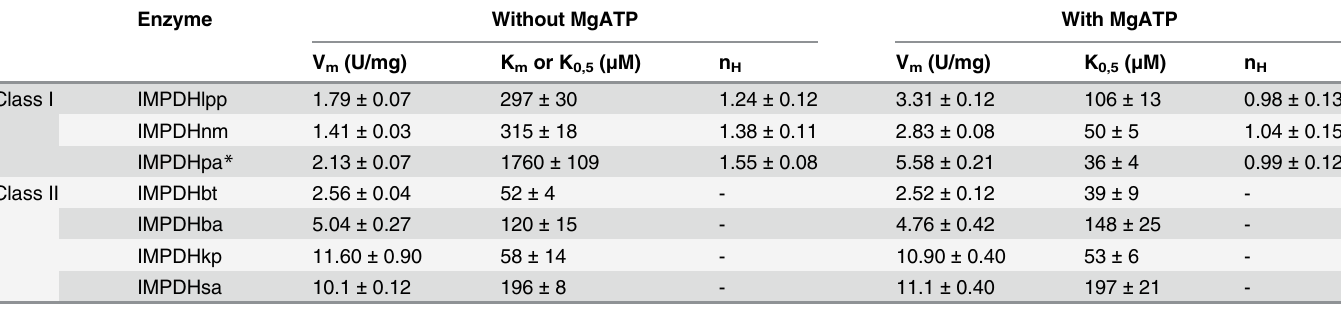
Table 6. Kinetic parameters of seven bacterial IMPDHs, with IMP as variable substrate. Reaction rates were determined at a constant concentration of NAD (2 mM for IMPDHbt, IMPDHba and IMPDHpa; 3 mM for IMPDHnm; 5 mM for IMPDHkp; 6 mM for IMPDHlpp and IMPDHsa) and in the absence or the presence of MgATP (2 mM for IMPDHnm; 3 mM for IMPDHpa, IMPDHbt, IMPDHba, IMPDHkp and IMPDHsa; 5 mM for IMPDHlpp), and fi tted according to the Michaelis-Menten equation (IMPDHbt, IMPDHba, IMPDHkp and IMPDHsa) or the Hill equation (IMPDHpa, IMPDHlpp and IMPDHnm) (see under Materials and